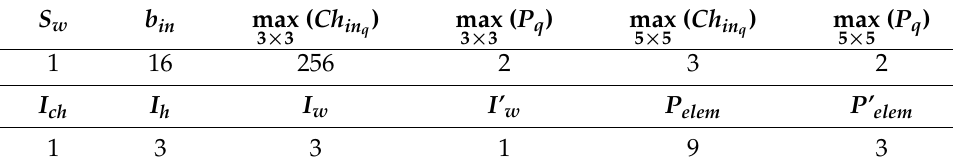
Table 1. System parameters.